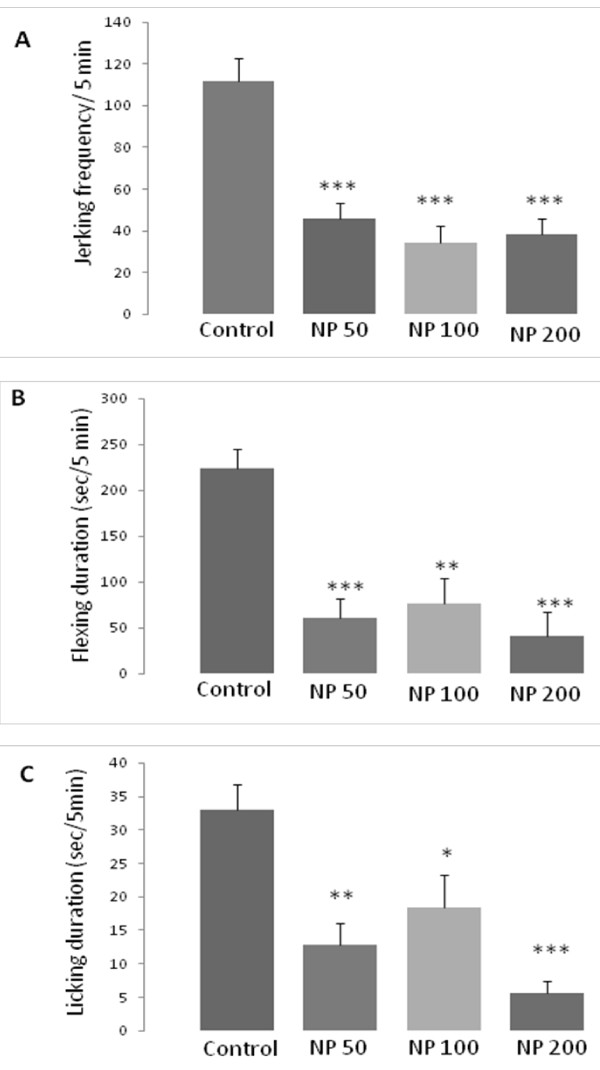
Antinociceptive effect of different doses of the essential oil of Nepeta pogonosperma (NP) in the late phase of formalin test (minutes 16 – 60). NP doses reduced all pain behaviors including jerking (A), flexing (B) and licking (C). Each bar symbolizes for mean ± S.E.M. for 6 rats. * = p <0.05, ** = p <0.01, ***p <0.001 compared to control.